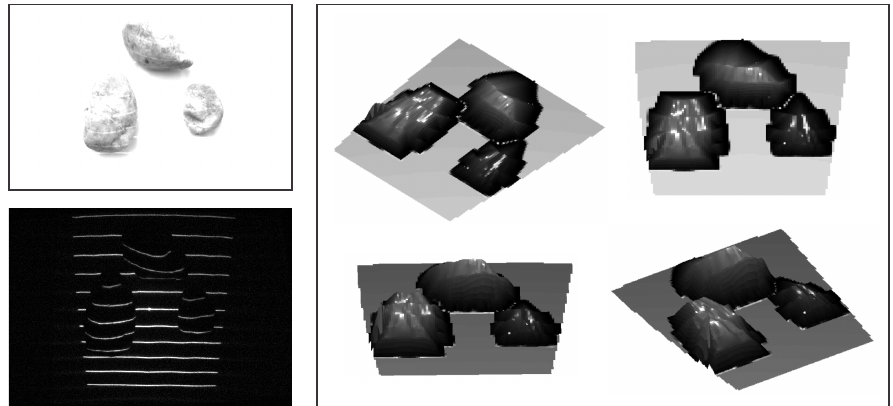
Figure 17. A visual example of the 3D reconstruction capabilities of the developed sensor. The image in the upper left corner shows a (visible light) image of the observed scene captured under strong incident sunlight; the image in the lower left corner shows the image of the detected light pattern; and the image on the right shows the reconstructed depth image from various angles.